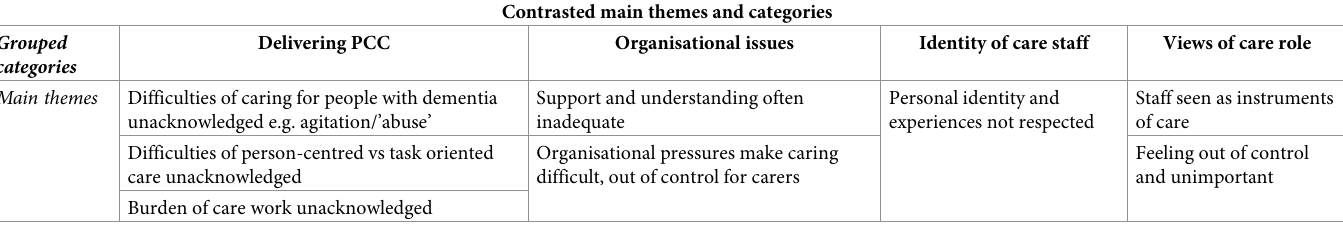
Table 4. Contrasted main themes and